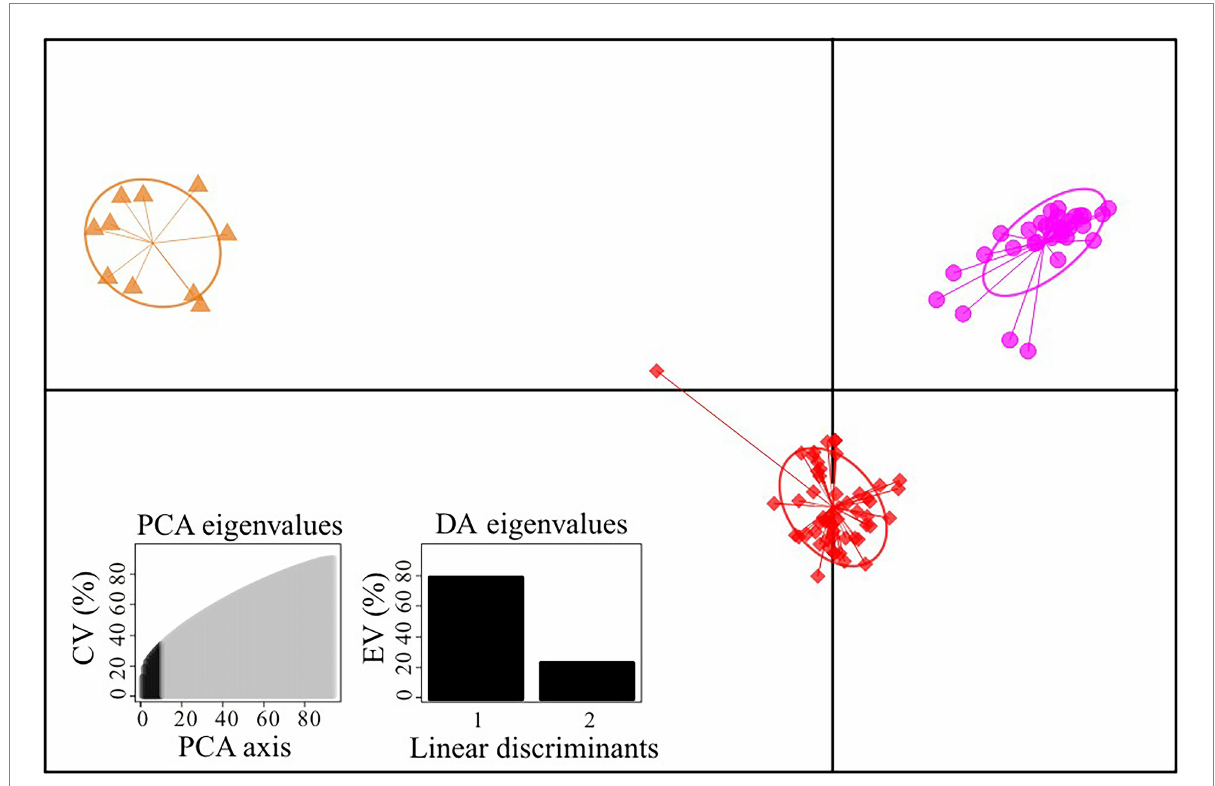
FIGURE 2 Scatterplot of DAPC analysis in the Gentiana hexaphylla complex using 1,907 SNPs. Clusters and inertia ellipses are shown in different colours, consistent with Figure 1. Each dot represents an individual. Insets show histograms of discriminant analysis eigenvalues. CV, cumulated variance; EV, explained